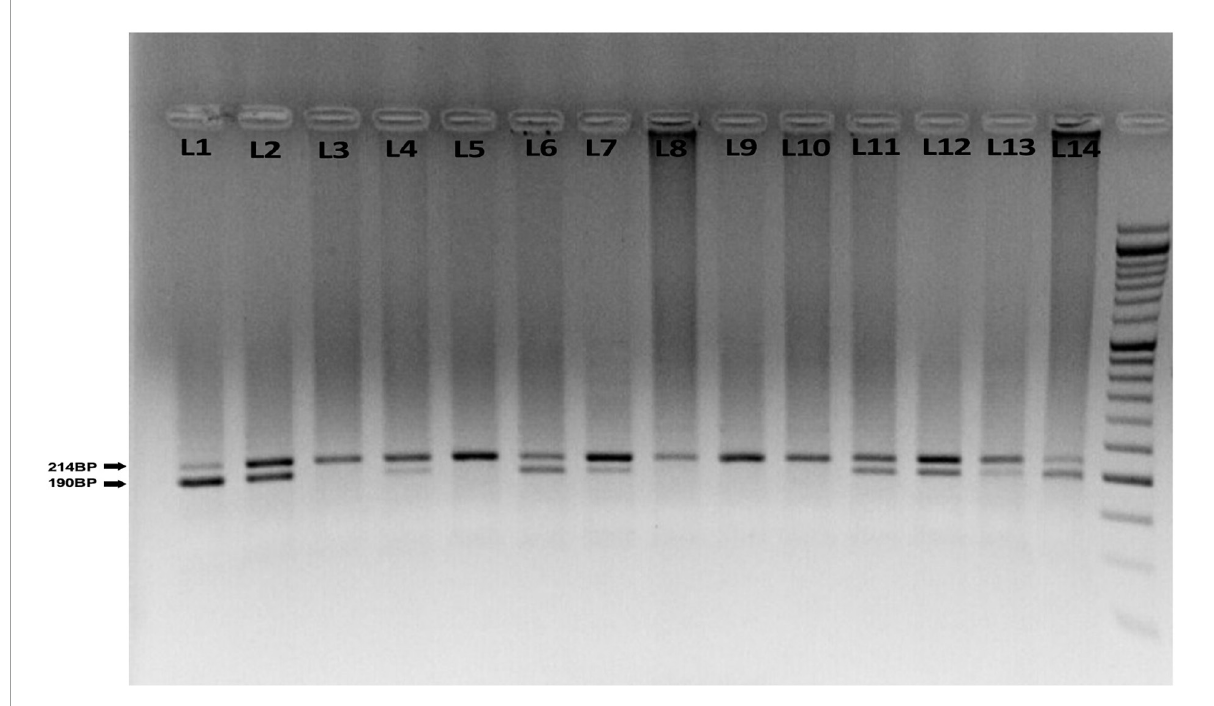
FIGURE1 Agarose gel electrophoresis for the rs662 polymorphism of paraoxonase 1 (PONl) gene. The 214 bp bands correspond to wild homozygous QQ genotype produced one fragment, while 190, 214, and 24 bp correspond to heterozygous QR that produced three fragments. The 190 and 24 bp correspond to variant homozygous RR genotype produced two fragments. The 24 bp was invisible in the gel due to its fast migration speed. About 50 bp ladder marker (L1), QQ genotype (L3, 5, 8, 9, 10), QR genotype (L2, 4, 6, 7, 11, 12, 13), and RR genotype (L1,